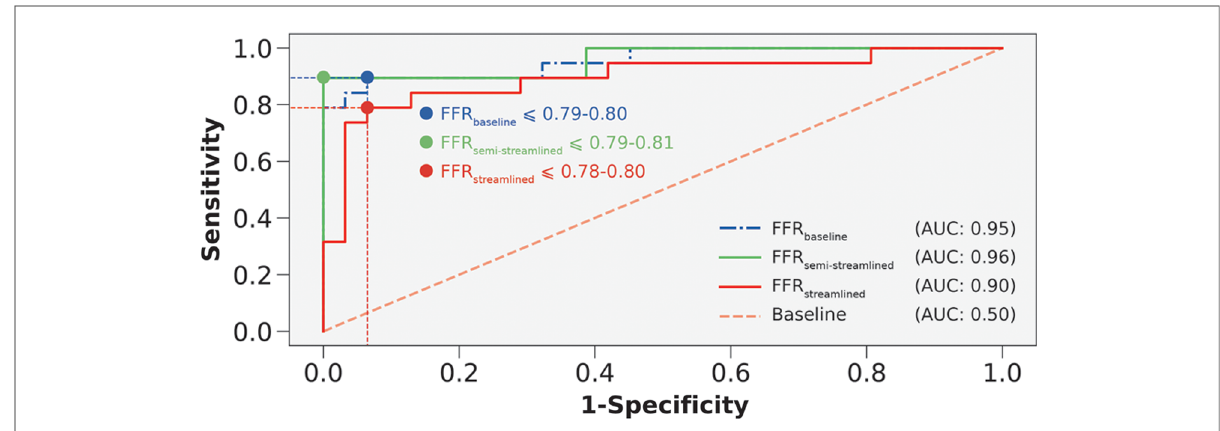
FIGURE 6 Receiver-operating characteristics curves to compare FFR semi (cid:1) streamlined , FFR streamlined , and FFR baseline . AUC is area under the curve. Interrupted vertical and horizontal lines indicate the sensitivity and 1-speci fi city values that correspond to the optimum threshold. Blue, green, and red colored circles represent the threshold overlaid on the receiver-operating characteristics